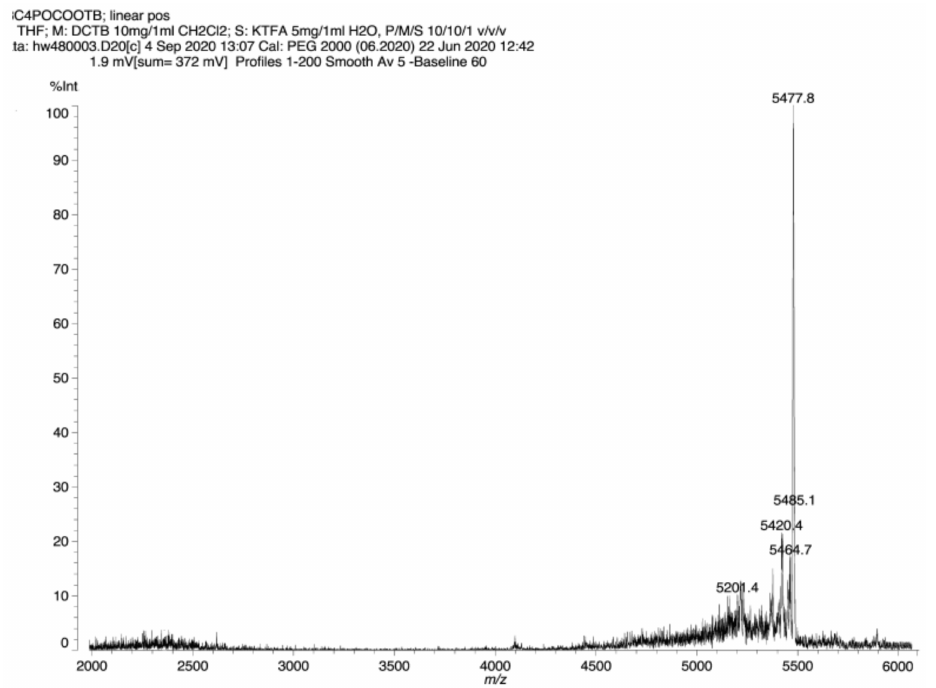
Figure 1. The MALDI TOF MS spectrum of dendrimer 10